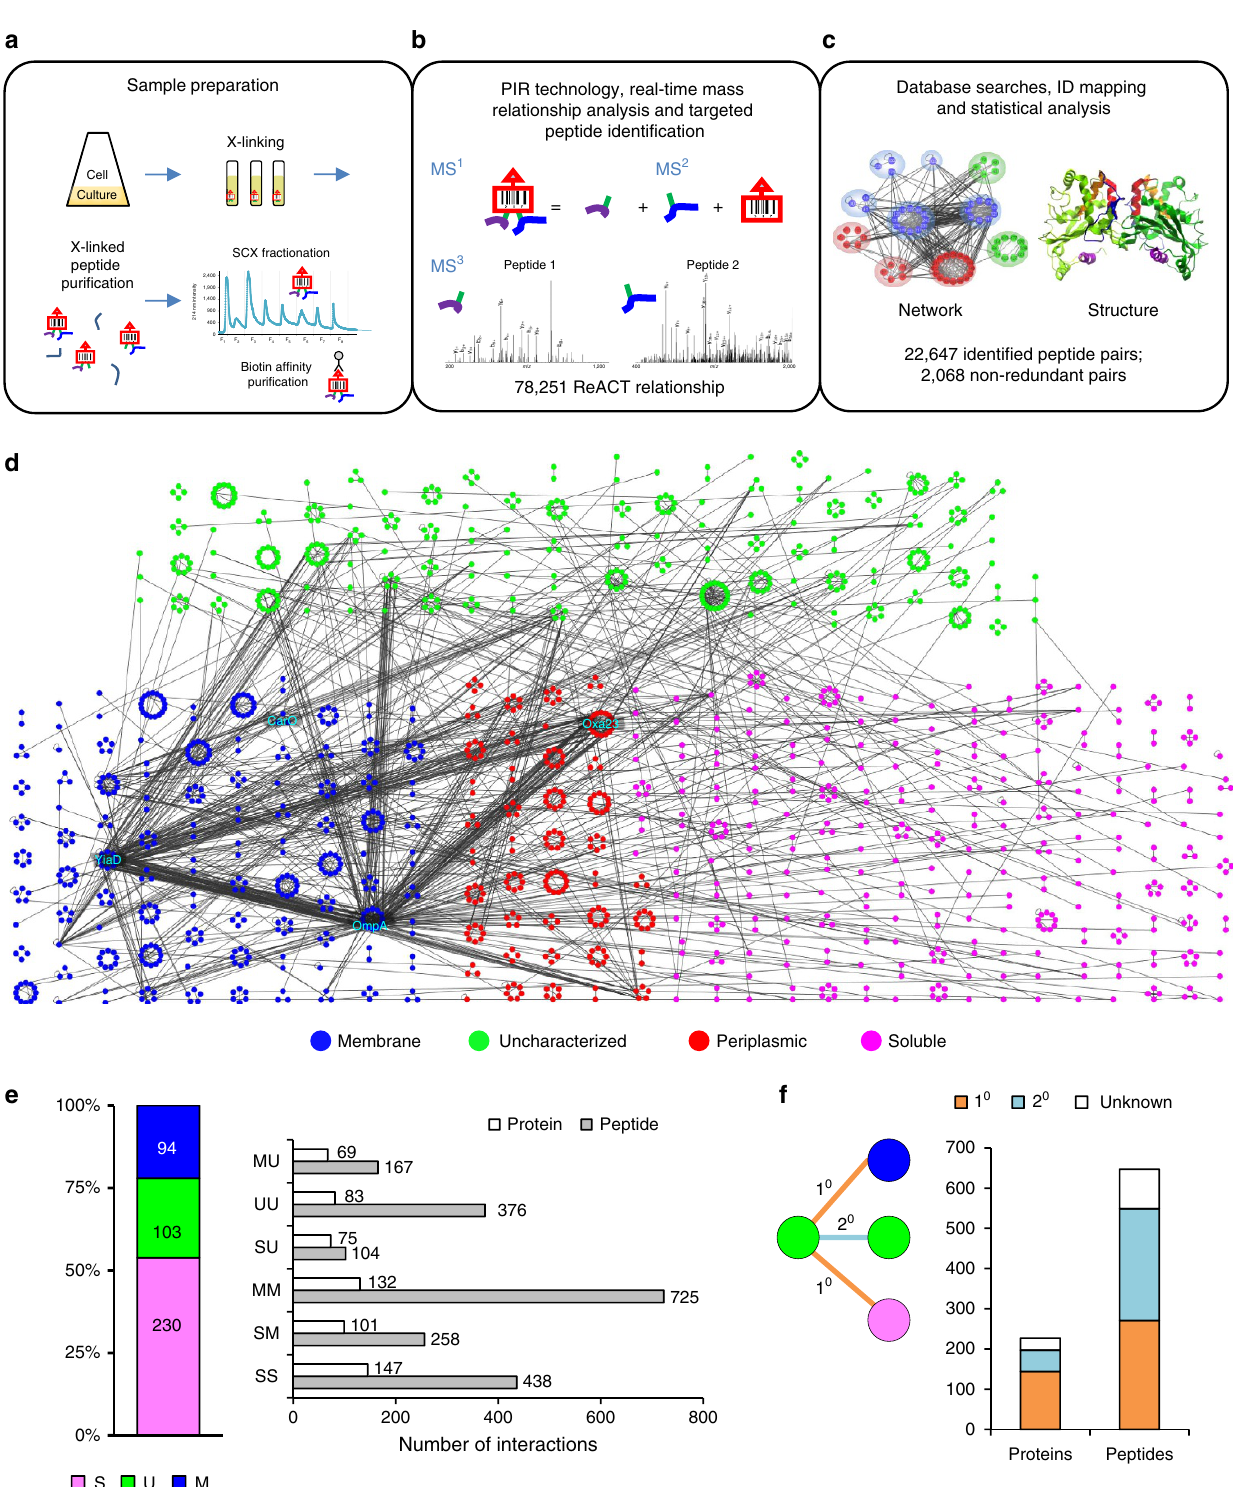
Figure 1 | Identification of in vivo protein interactions in A. baumannii cells. ( a – c ) Schematic overview of experimental procedures. ( d ) Protein interaction network in AB5075 cells comprising 2,068 non-redundant cross-linked peptide pairs. Nodes indicate the identified cross-linked sites and were grouped into circles to represent proteins. Node colours illustrate the protein primary subcellular localization. Blue, membrane proteins; green, uncharacterized proteins; magenta, soluble proteins; red, soluble proteins predicted to be localized in periplasm 47,48 . Edges represent the identified cross-links between the two sites. Protein interaction hubs OmpA, YiaD and Oxa-23, as well as OM porin CarO are highlighted. Uncharacterized proteins were identified cross-linked to membrane, periplasmic and soluble proteins. ( e ) Composition of protein nodes (M, membrane proteins; S, soluble proteins; U, uncharacterized proteins) and edges in the network based on subcellular localization. Edges: MM, cross-links between membrane proteins; MU, cross-links of membrane proteins to uncharacterized proteins; SM, cross-links of membrane proteins to soluble proteins; SS, cross-links between soluble proteins; SU, cross-links of soluble proteins to uncharacterized proteins; UU, cross-links between uncharacterized proteins. ( f ) Cross-links between the uncharacterized proteins and the functionally annotated proteins, either directly (1 (cid:2) interactions) or through an intermediate partner (2 (cid:2) interactions), could shed light on the function for these uncharacterized